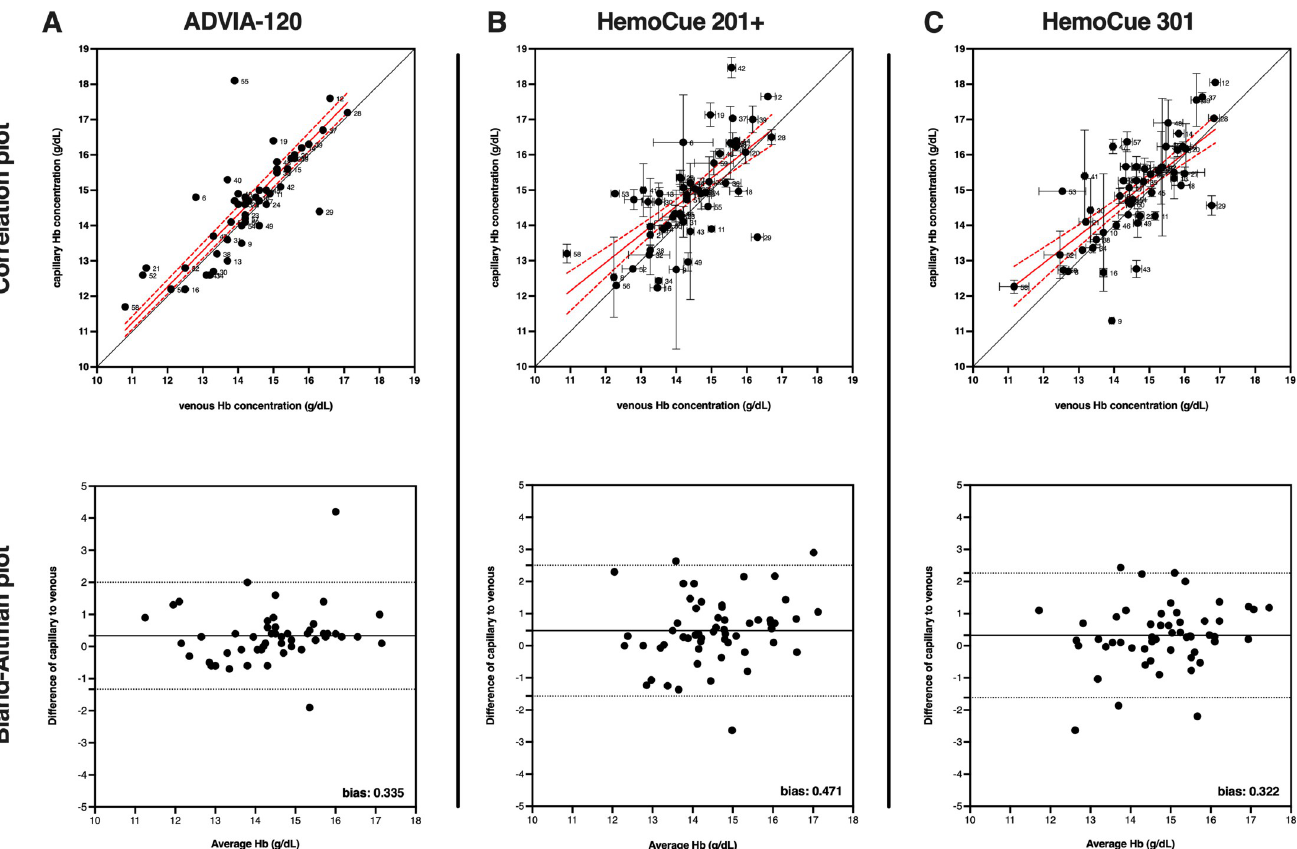
Fig 2. Hemoglobin concentration is elevated in capillary compared to venous blood. Correlation and Bland-Altman plots for Hb values determined in capillary and venous blood from the same participants measured by ( A ) ADVIA-2120, ( B ) HemoCue 201+, and ( C ) HemoCue 301. The correlation plots show the capillary and venous Hb values (mean ± SEM) proximity to line of concordance (solid black line), as well as linear regression (solid red line) ± 95% confidence interval (red dotted line) for the group. Each circle represents a single participant, with participant ID number to the immediate right. The Bland-Altman plot shows a bias for capillary over venous values as ( A ) 0.34 ± 0.85 g/dL for ADVIA-2120, ( B ) 0.47 ± 1.04 g/dL for HemoCue 201+, and ( C ) 0.32 ± 0.99 g/dL for HemoCue